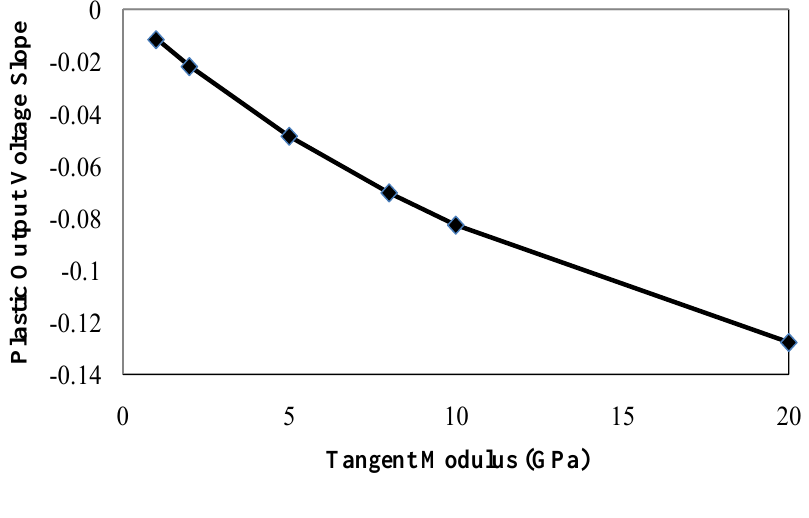
Figure 14. Comparison of the slope of the output voltage to the plastic tangent modulus.